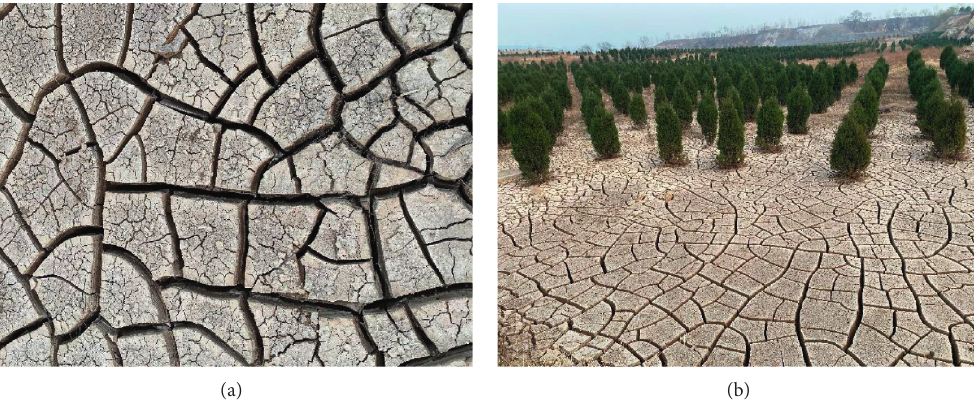
Figure 8: Drying cracks in the nature and the corresponding control measures. (a) Drying cracks in the nature. (b) Control measures for the cracks by tree